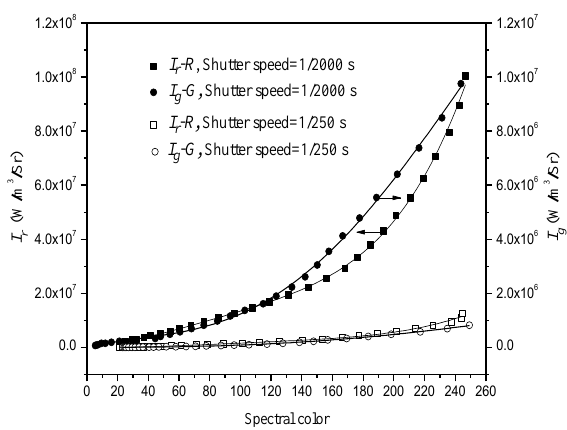
Figure 4. Characteristic calibration for the CCD camera. Table 1. Calibration errors of spectrometer and CCD camera.